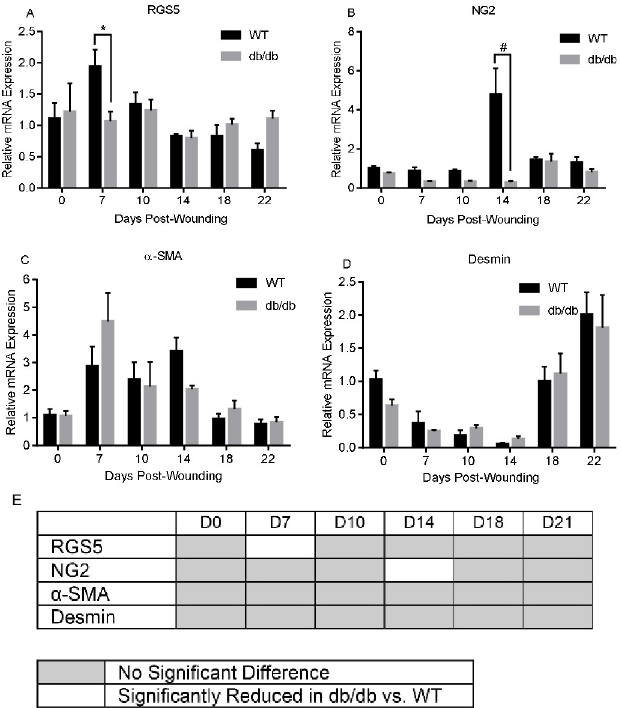
Fig 5. A-D) Semi-quantitative RT-PCR analysis of pericyte markers in mouse diabetic wounds over the time course of wound healing. n = 5, � p > 0.05, #p < 0.01. E) Heatmap summarizing findings of A-D, showing genes with no difference (gray boxes) significant downregulation (white boxes) or upregulation (black boxes) over the time course of healing in db/db versus WT mice. In the figure, factors are identified using common protein name abbreviations; for gene symbols see Table 3.